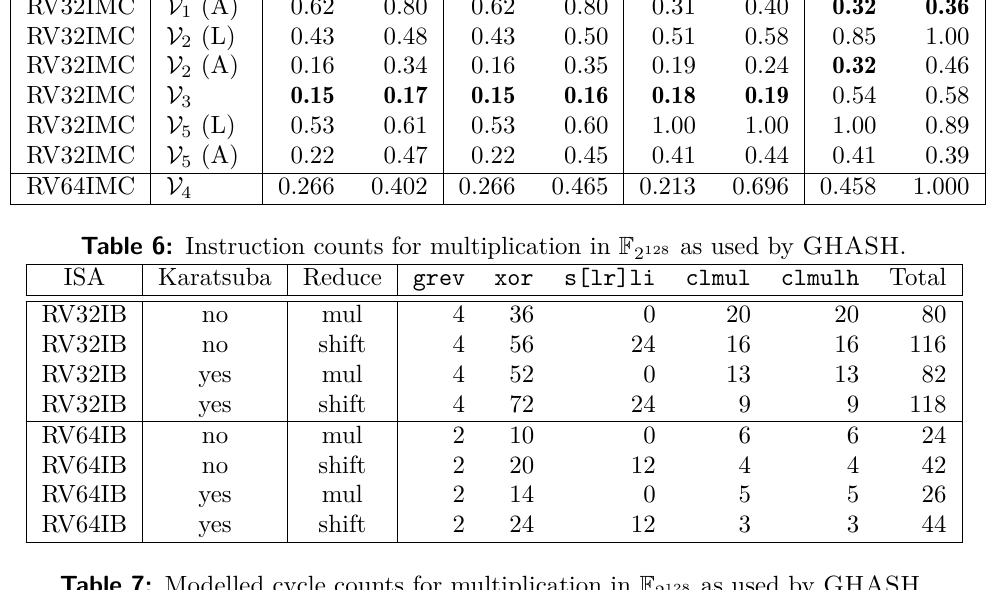
Table 7: Modelled cycle counts for multiplication in F